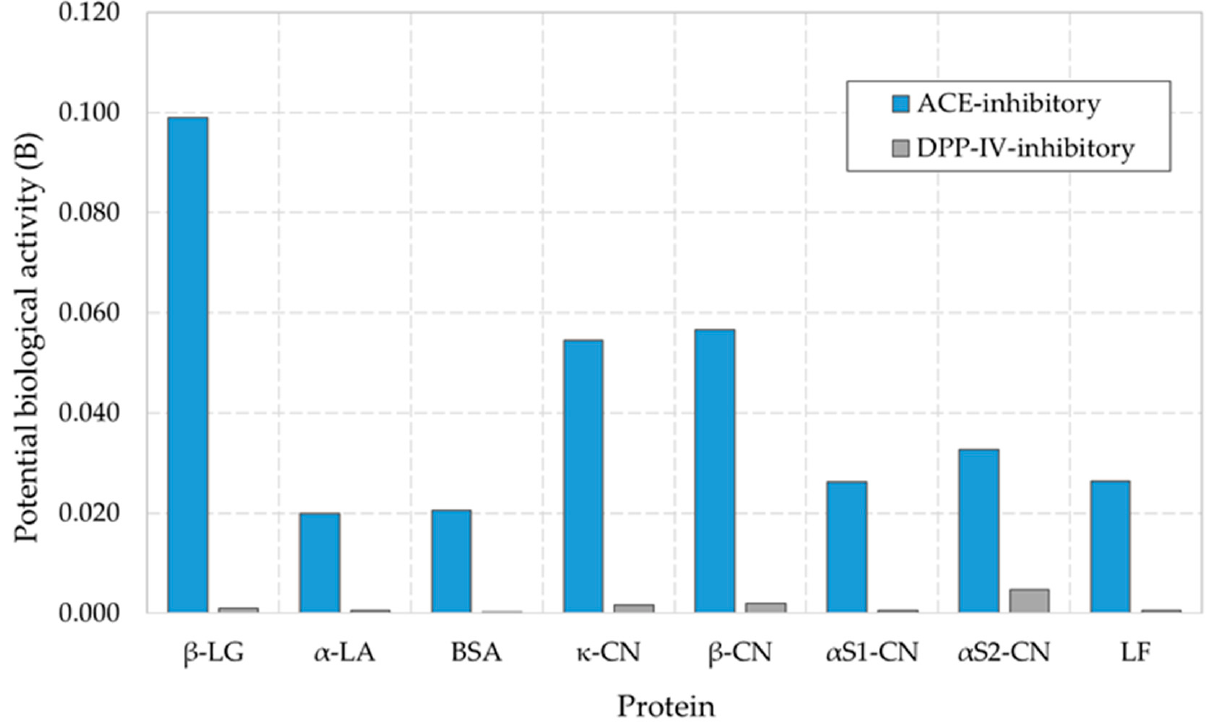
Figure 3. Potential biological activity (B) in major milk whey proteins.